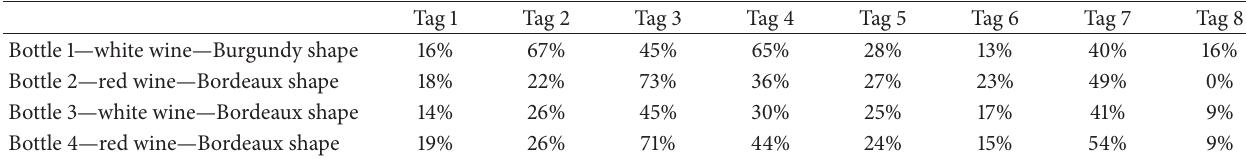
Table 5: Percentage of reduction in the reading arc around the bottle due to the influence of wine.